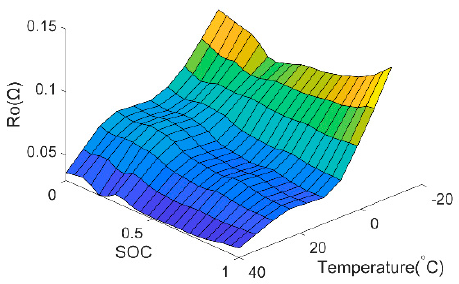
Figure 11. Ohmic resistance identification results at different temperatures.